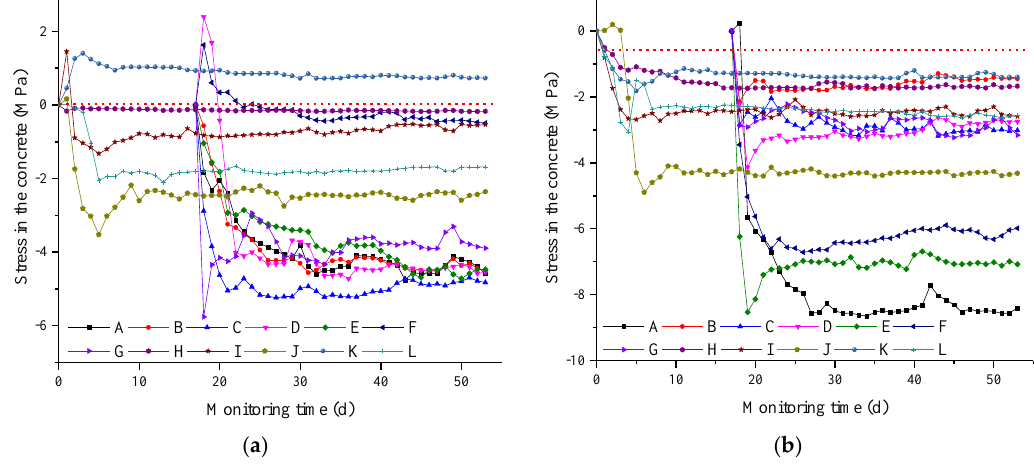
Figure 25. Time history curves of the stresses in the concrete of the secondary supports: ( a ) inner side; ( b ) outer side.